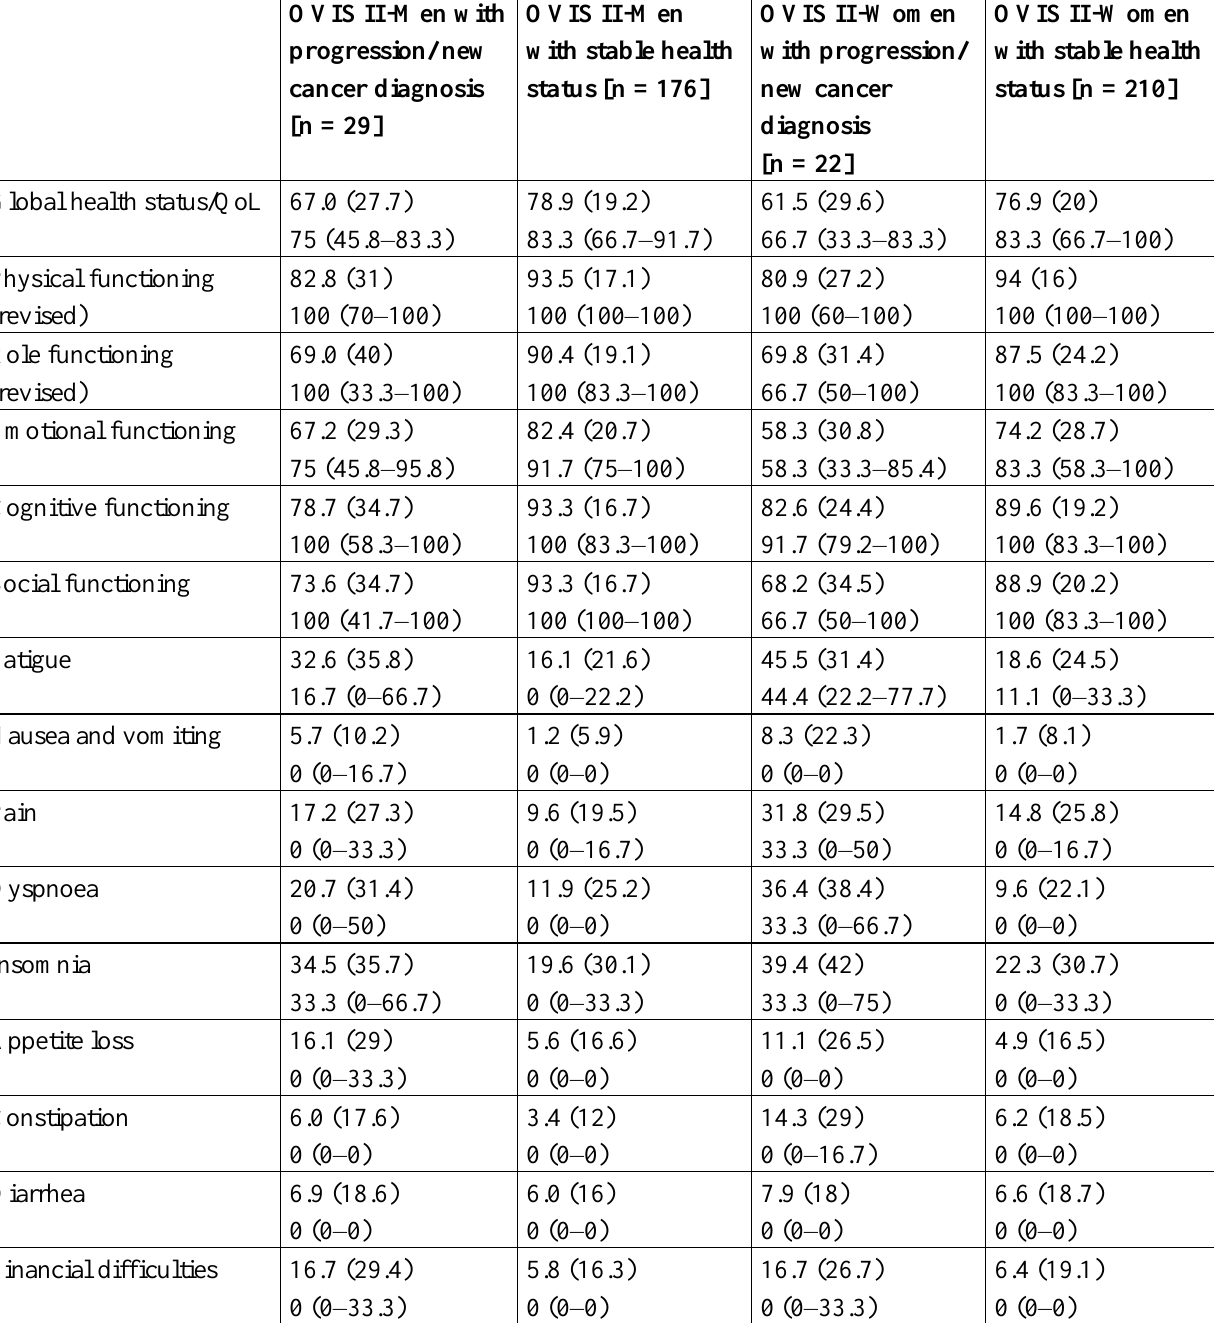
Table 5. Mean (SD) and median (25th–75th percentiles) EORTC QLQ-C30 scores of German melanoma patients at follow-up (Q2; OVIS II) according to health status (progression or new cancer diagnosis vs. stable health